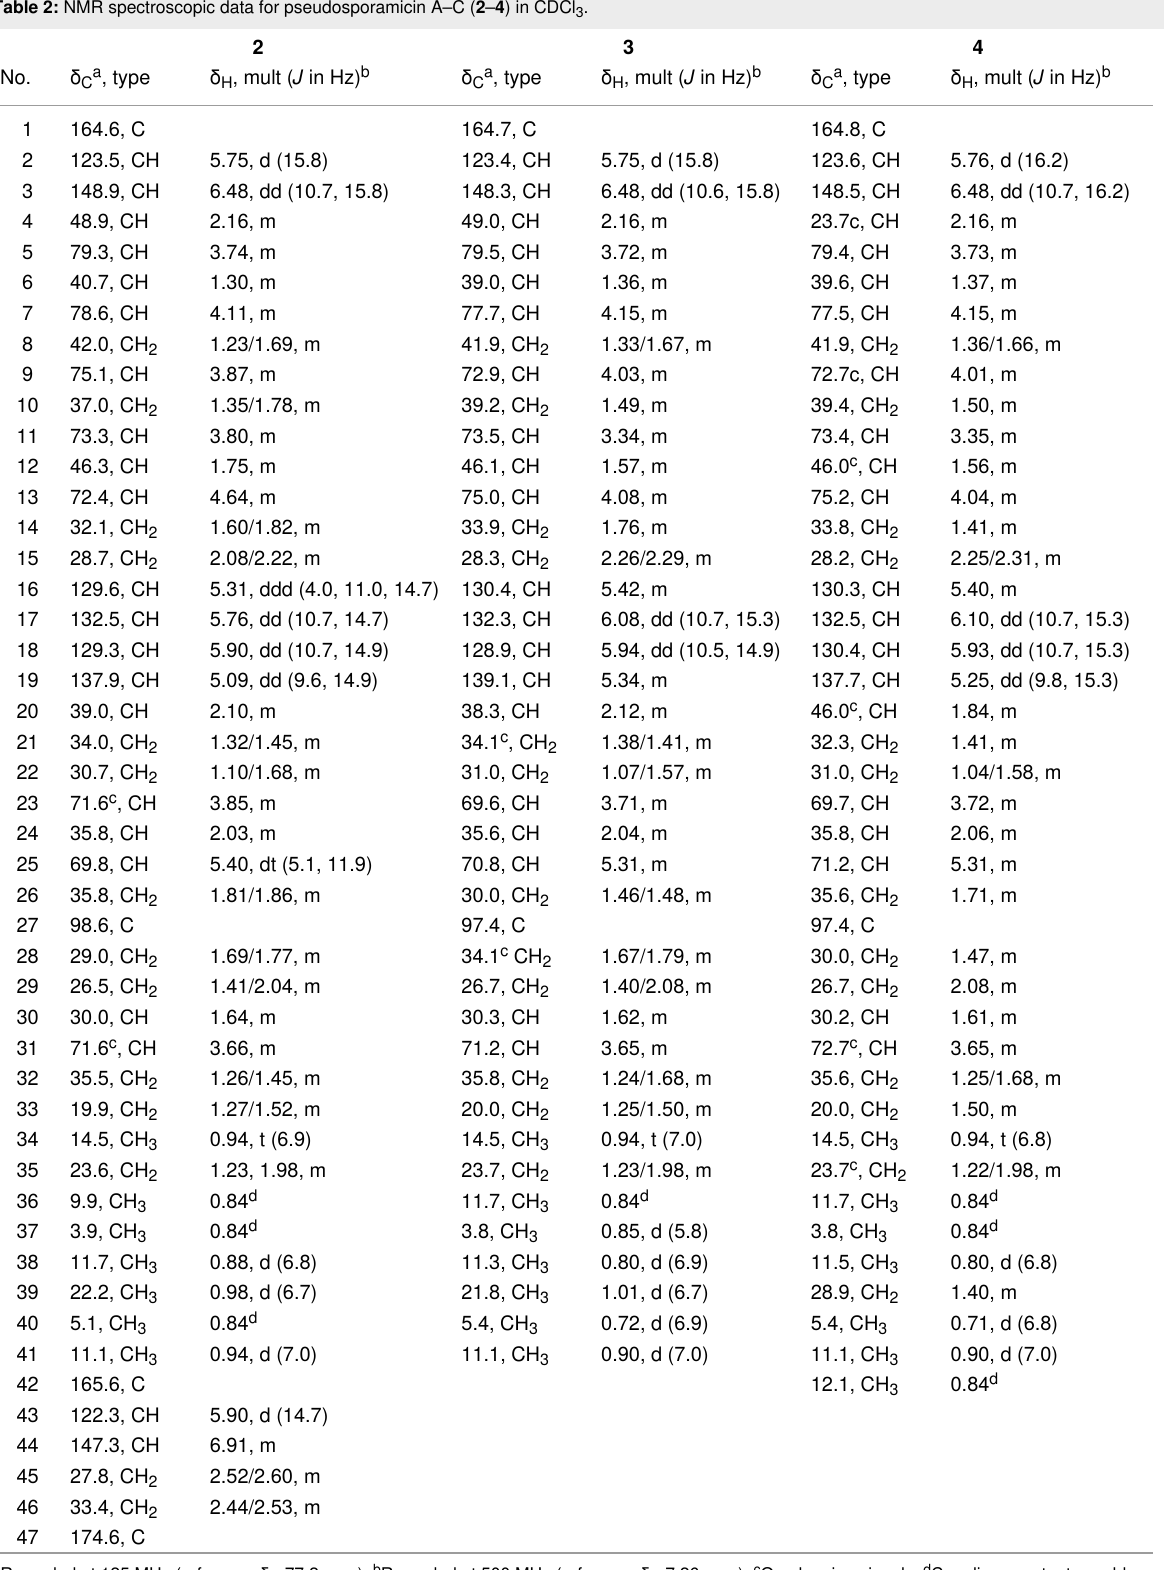
Table 2: NMR spectroscopic data for pseudosporamicin A–C ( 2 – 4 ) in CDCl 3